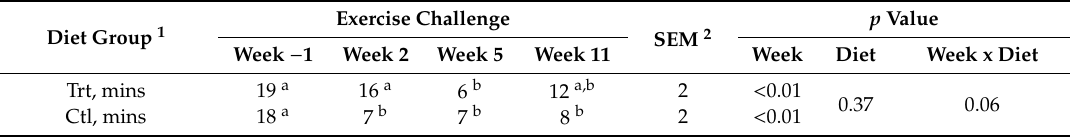
Table 4. Least square mean respiratory rate (breathing frequency) at rest, work, and post-exercise on week − 1, 2, 5, and 11 challenges in sled dogs running at a pace of 15 km / h for 4 km. p Value Exercise Challenge Activity Parameter 1 SEM 2 Week − 1 Week 2 Week 5 Week 11 Week Diet Week x Diet totalRR, bf 3 75 a 73 a,b 69 b 68 b 1 < 0.01 0.36 0.81 rRR, bf 23 a 19 a,b 15 c 16 b,c 1 < 0.01 0.66 0.12 wRR, bf 176 a 172 a 174 a 169 a 4 0.50 0.86 0.74 postRR, bf 27 a 26 a 18 b 20 b 1 < 0.01 0.17 0.55 1 totalRR, total mean respiratory rate; rRR, resting respiratory rate; wRR, working respiratory rate; postRR, post-exercise respiratory rate. 2 SEM, standard error of the mean, n = 14 for rRR (week − 1), n = 16 for rRR (weeks 2,